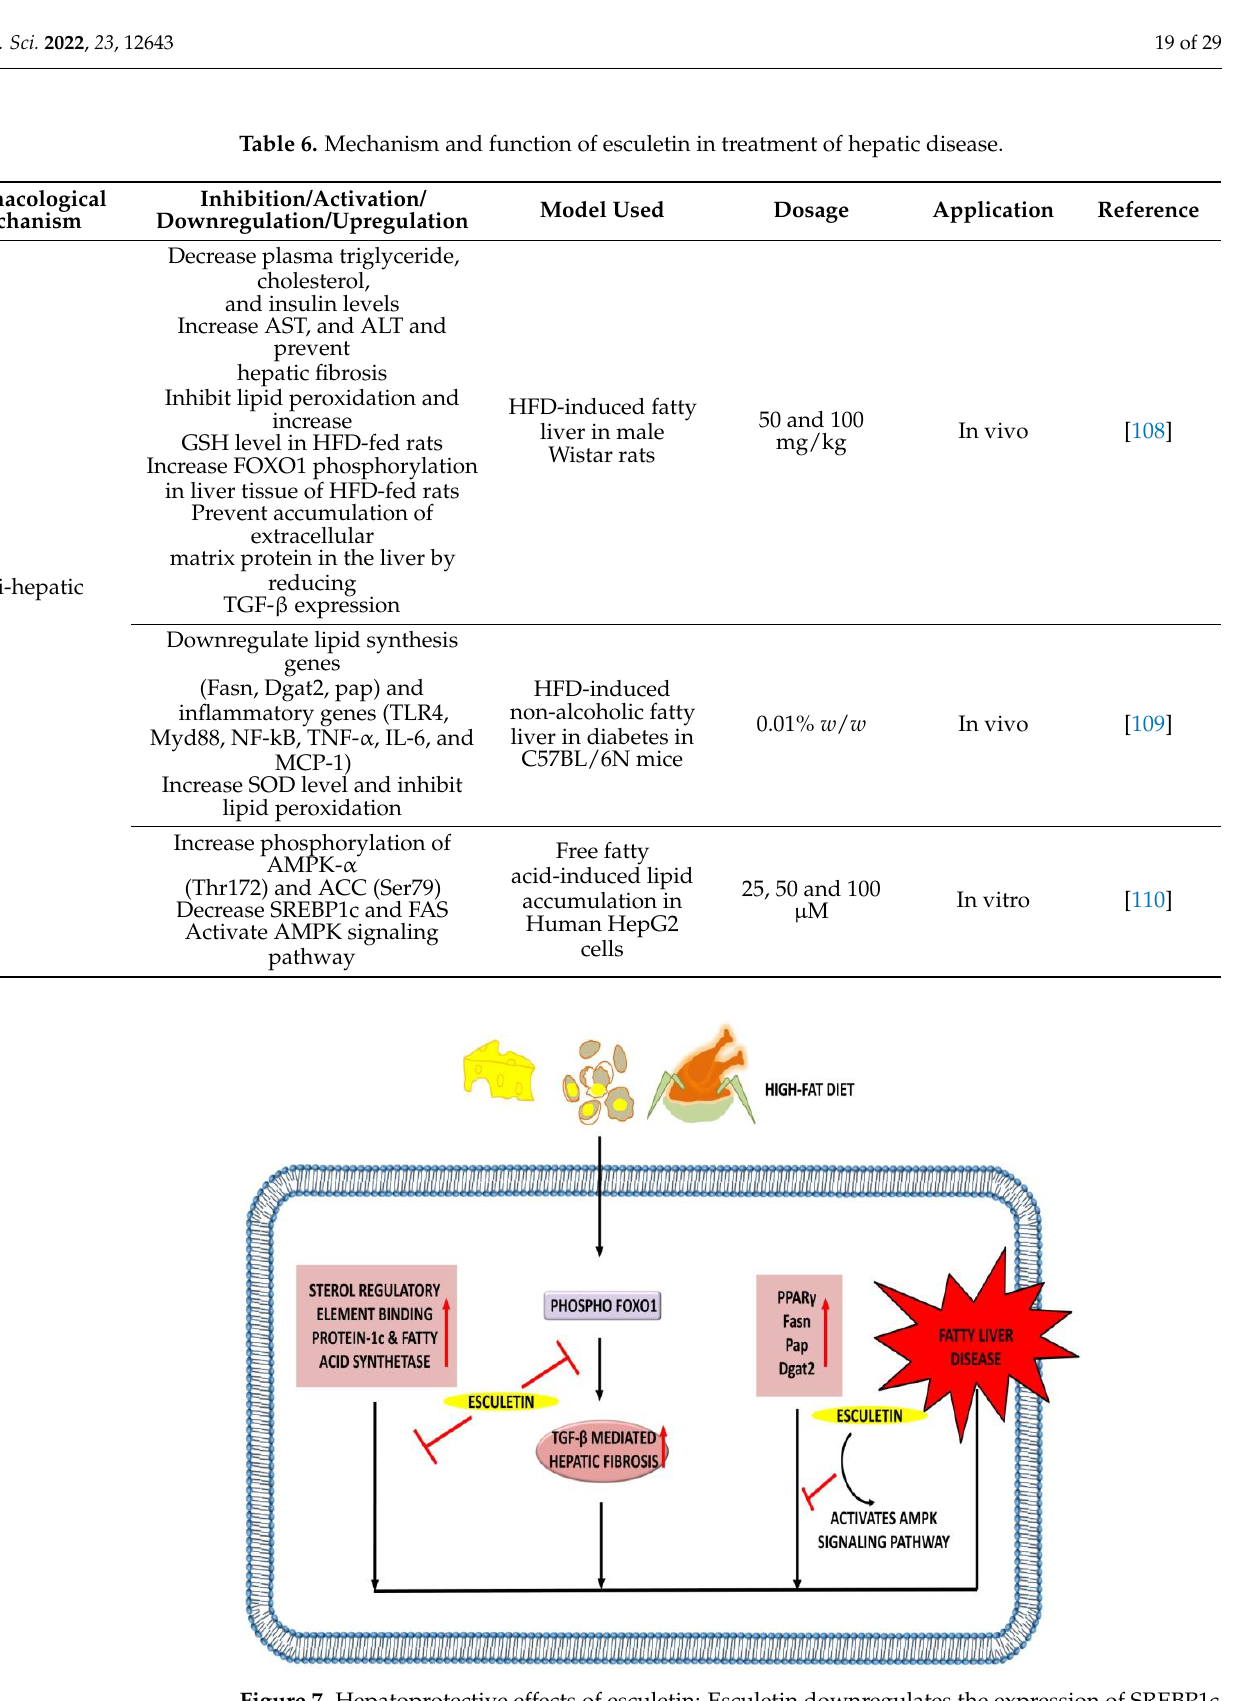
Figure 7. Hepatoprotective effects of esculetin: Esculetin downregulates the expression of SREBP1c, fatty acid synthetase, and TGF- β -mediated hepatic fibrosis. Esculetin also activates AMPK signal- ing pathway and inhibits the action of PPARγ, Fasn, Pap, and Dgat2, th us inhibiting the patho- genesis of the fatty liver disease. : Overexpression; :